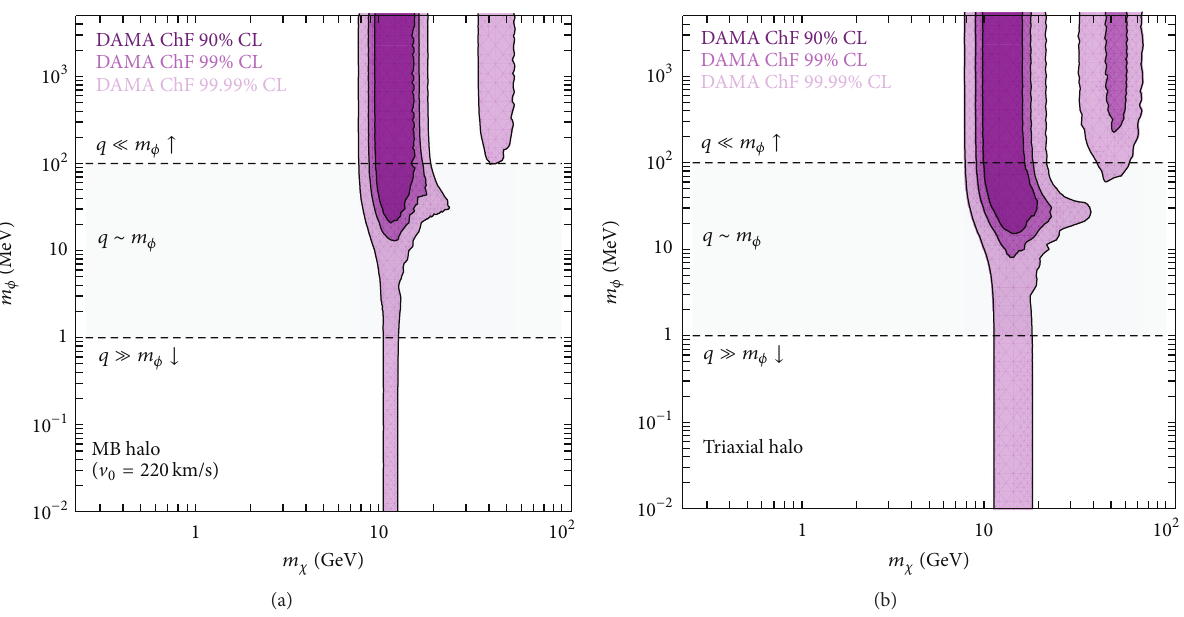
Figure 4: The bounds on the mediator mass as a function of the DM one obtained by comparing the DAMA modulated signal with the total rate. The allowed regions are reported for CLs of 90%, 99%, and 99.99% in shaded magenta. In (a) an isothermal sphere with velocity dispersion V 0 = 220 km/s and a local DM energy density 𝜌 ⊙ = 0.3 GeV/cm 3 has been assumed. In (b) we instead show the allowed regions by considering a more physical triaxial halo with the same velocity dispersion in the major axis and with 𝜌 ⊙ = 0.84 GeV/cm 3 . These results have been presented in [24, 25].